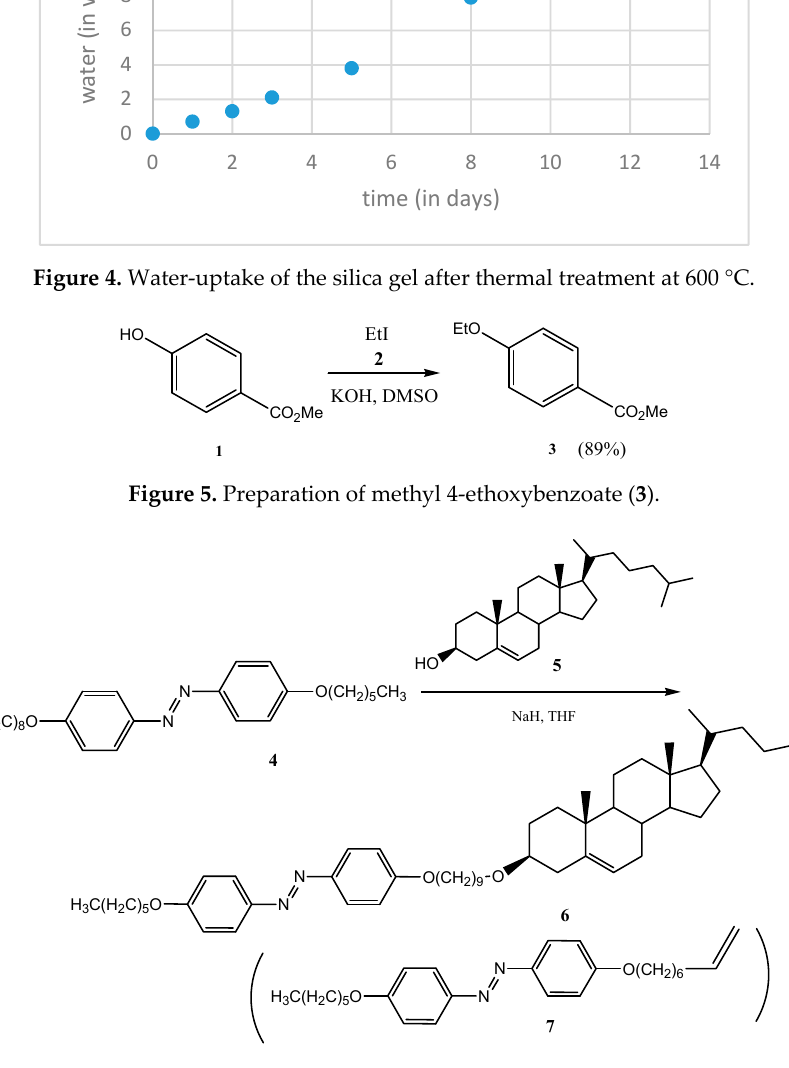
Figure 6. Williamson ether synthesis of steroidal azobenzene 6 .